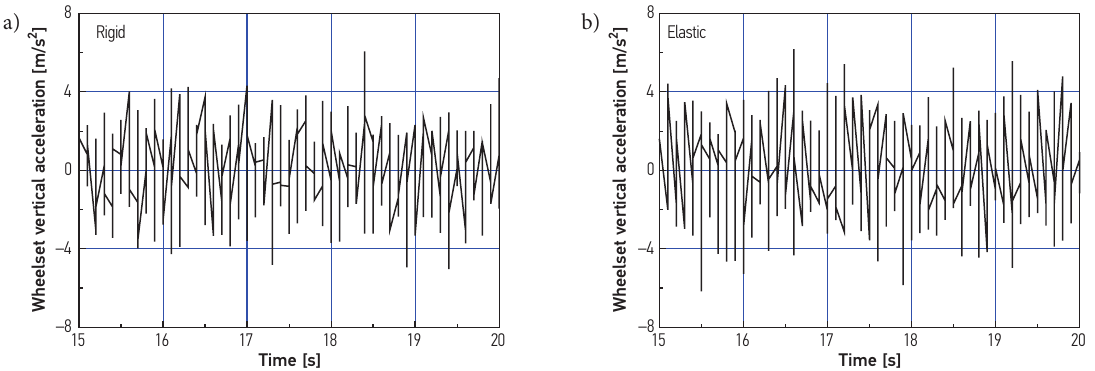
Fig. 11. Time history of wheelset vertical accelerations as a function of rigid and elastic model: a – rigid; b – elastic